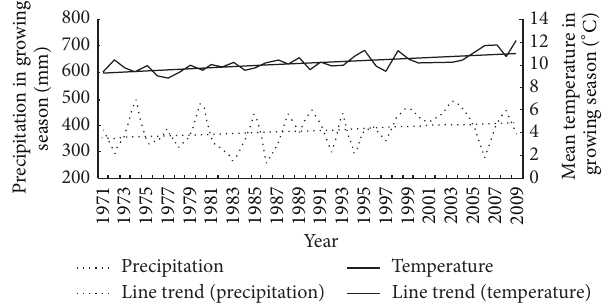
Figure 3: Variability of temperature (1971–2009, solid line) and precipitation (1971–2009, dotted line) in the growing season at three meteorological stations (Damxung, Bange, and